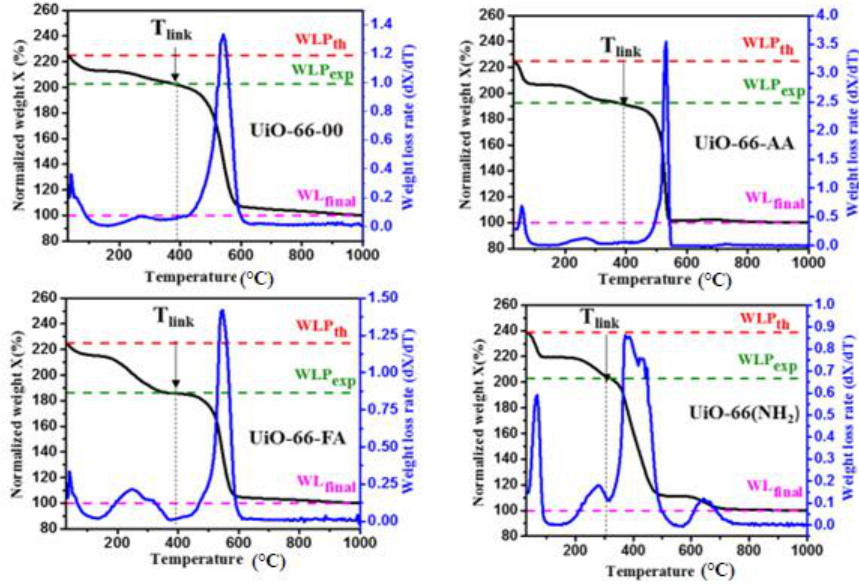
Figure 4. TGA and DTG curves of the synthesized MOFs.